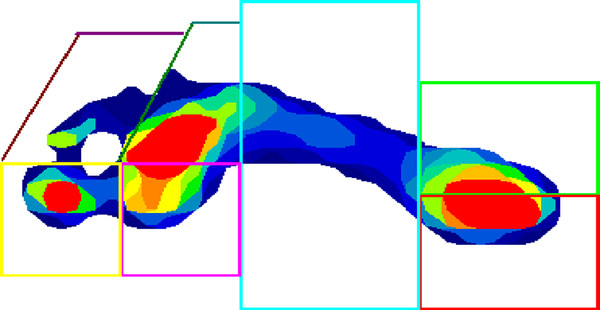
An example of a typical walking trial produced by the TekScan MatScan® system, displaying the seven masked regions used during analysis.